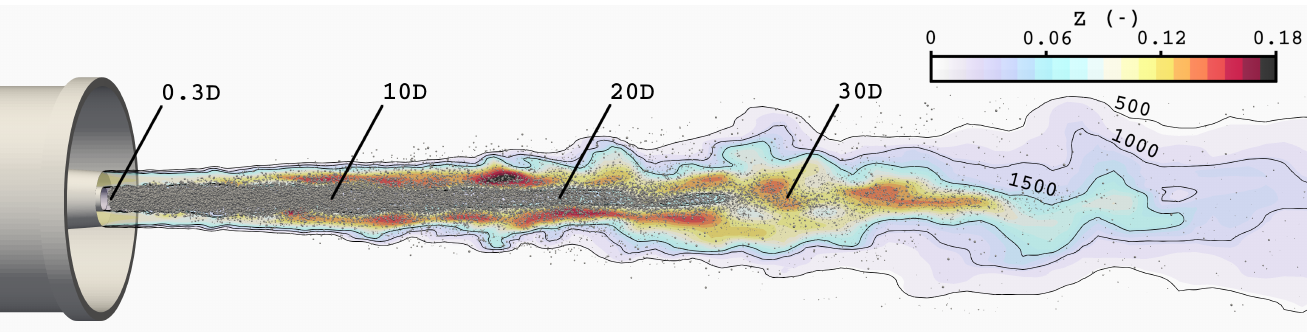
Figure 6. Instantaneous contours of mixture fraction superimposed with the Lagrangian parcels alongside isolines of temperature ( T = 500,1000,1500 K) for